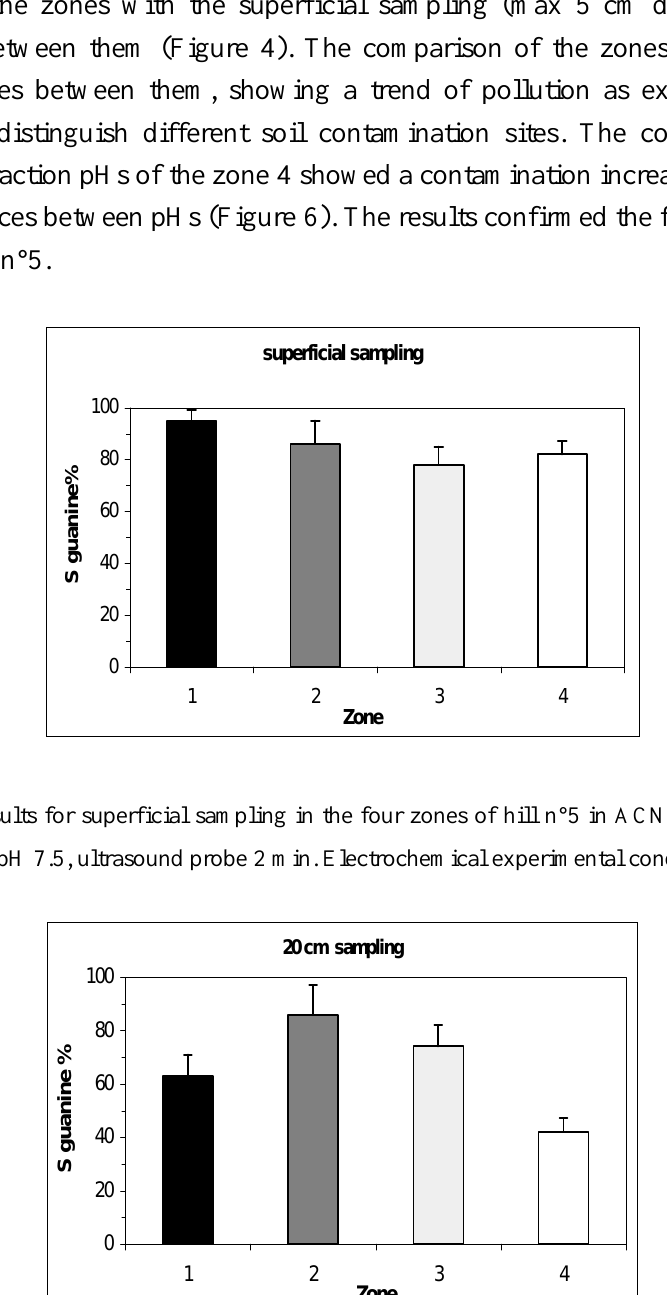
Figure 5. DNA biosensor results for 20 cm sampling in the four zones of hill n°5 in ACNA area (sampling of 2003). Extraction with 50 mM PBS pH 7.5, ultrasound probe 2 min. Electrochemical experimental conditions as in Figure